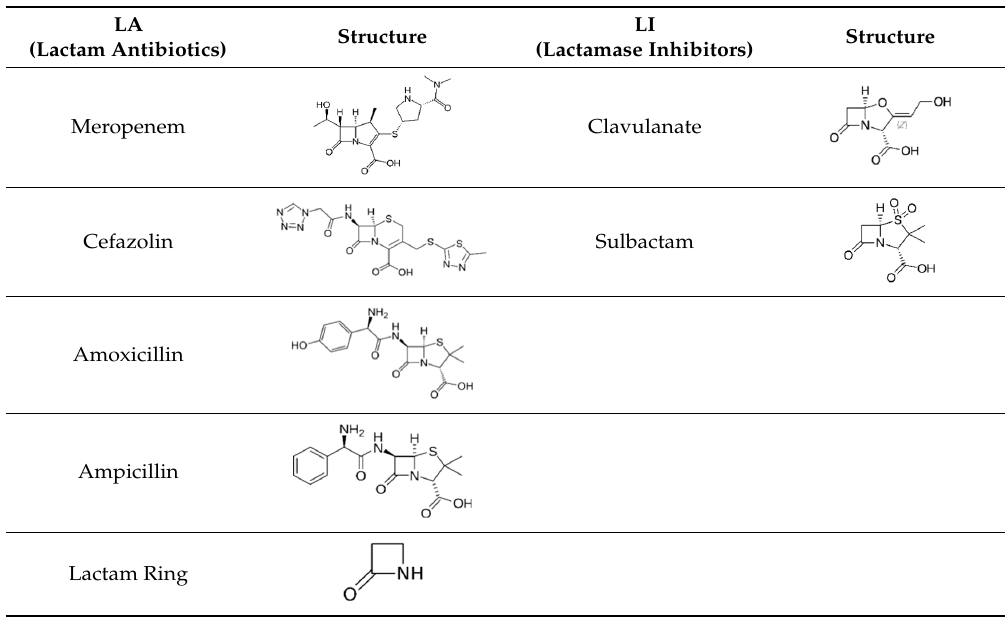
Table 1. Chemical structures of agents containing a lactam ring: Lactam antibiotics (LA) and Lactamase Inhibitors (LI). Lactamase Inhibitors (LI). Lactamase Inhibitors Lactamase Inhibitors (LI). Lactamase Inhibitors (LI).